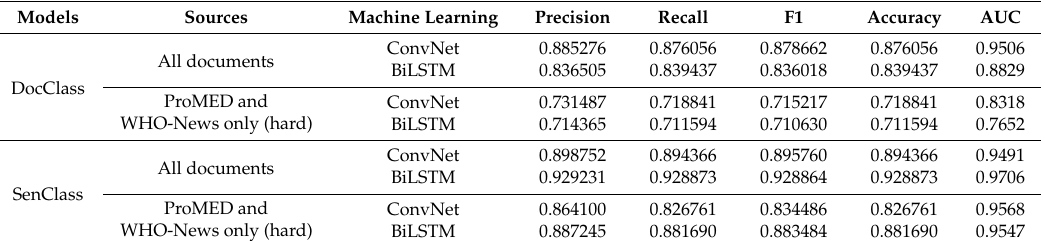
Table 5. Comparison of ConvNet and BiLSTM based on the precision, recall, F1, accuracy, and area under the curve (AUC) measurements.